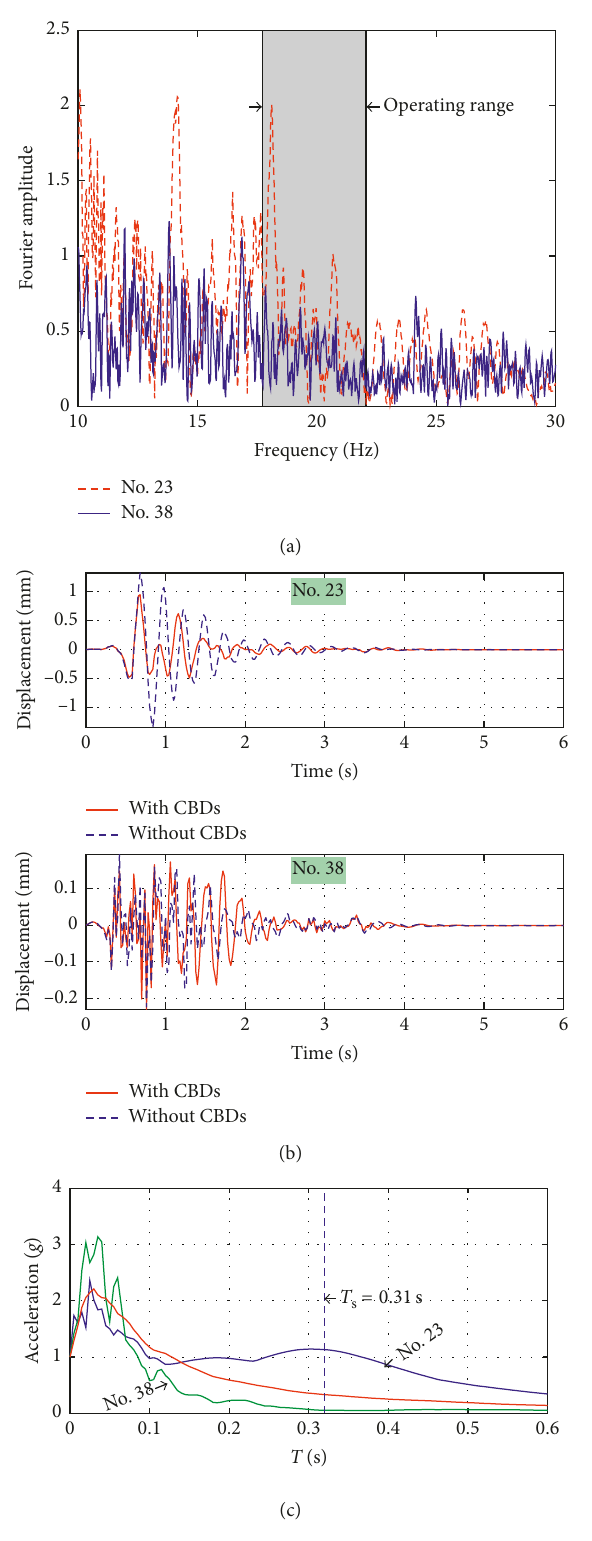
Figure 20: Reduction rates under 53 sets of seismic excitations. (a) Fourier amplitude spectrum of the 23rd and the 38th seismic excitations and the operating range of the structure with CBDs. (b) Comparison of interstory drift reduction rate between the 23rd and the 38th seismic excitations. (c) Response spectrum comparison between the 23rd and the 38th seismic excitations.